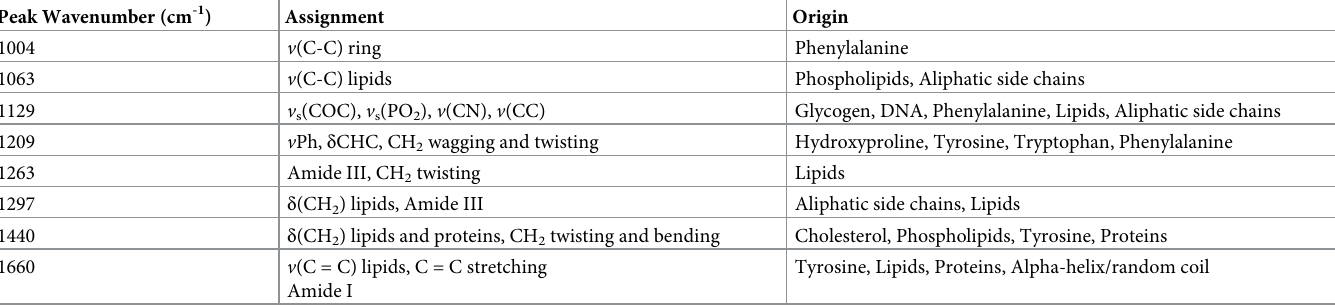
v = stretching; v s = symmetric stretching; δ = in-plane bending, Ph =